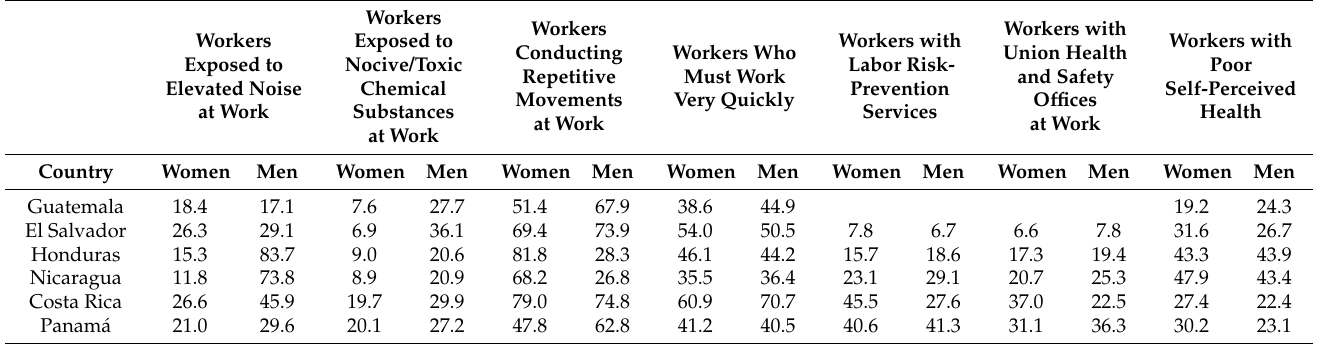
Table 1. Working conditions, self-perceived health, prevention resources, and occupational health offices in Central America in 2018 (n = 9000)